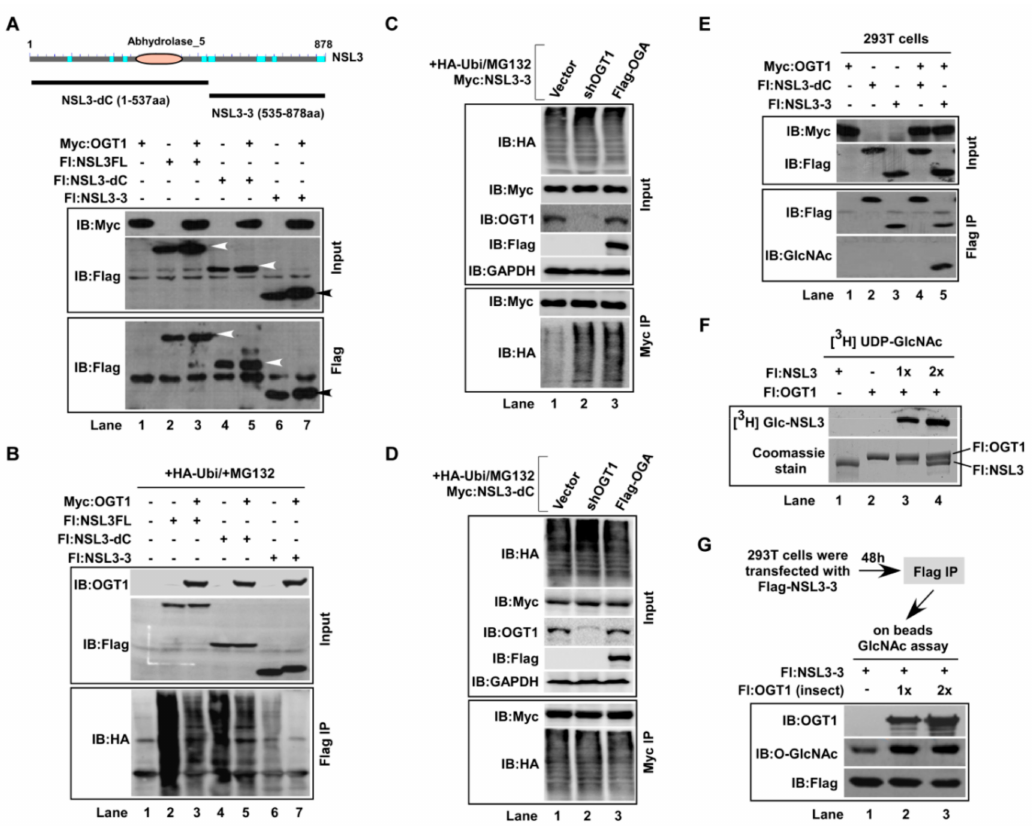
Figure 1. O -linked N-acetylglucosamine ( O -GlcNAc) transferase (OGT1) stabilized nonspecific lethal protein 3 (NSL3) through O -GlcNAcylating its C-terminus. “ + , − ” in figures caption means with or without. ( A ) Stabilization of NSL3 by OGT1: full-length or deletion mutants of NSL3 (upper panel) were co-transfected with OGT1 in 293T cells, and expressed proteins were analyzed using Western blot (WB) with anti-Flag or anti-Myc antibodies (lower panel). ( B ) Declined ubiquitin-mediated degradation of NSL3 by OGT1: degradation of NSL3FL or deletion mutants of NSL3 by OGT1 was observed in the presence of HA-ubiquitin and MG132 in 293T cells. ( C , D ) Regulation of O -GlcNAcylation on ubiquitin-mediated degradation of NSL3: ubiquitin-mediated NSL3-3 and NSL3-dC degradation was examined in transient transfection of shOGT1 or OGA 293T cells in the presence of MG132. ( E ) O -GlcNAc modification of NSL3-3 C-terminus by OGT1: 293T cells were co-transfected with Myc-OGT1 and Flag-tagged NSL3-dC or NSL3-3, and the O -GlcNAc modification on NSL3 was then detected by WB with anti- O -GlcNAc antibody followed by Flag IP at 48 h after transfection. ( F ) In vitro O -GlcNAc transferase assay: insect cells expressed and purified OGT1 and NSL3 proteins were incubated with UDP-[ 3 H] GlcNAc in the presence of reaction bu ff er. O -GlcNAc modification on recombinant NSL3 was measured by autoradiography (upper), recombinant OGT1 and NSL3 were visualized by Coomassie Brilliant Blue staining (lower). ( G ) On beads O -GlcNAc-assay: 293T cells were co-transfected with Flag-NSL3-3 and OGT1, 48 h after transfection, bound Flag-NSL3-3 was subjected to in vitro O -GlcNAc transferase assay. Modified NSL3-3 was detected with specific anti- O -GlcNAc